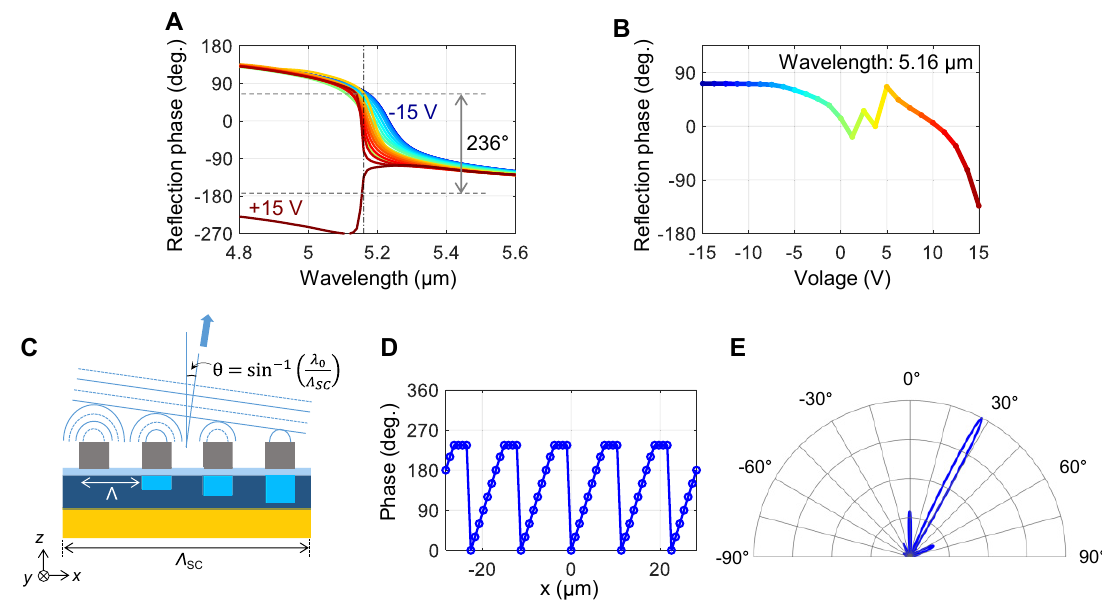
Figure 4: Phase modulation and beam steering of mid-infrared light. (A)Reflectionphasespectrumfordifferentvoltagesof − 15V(theblueline)to + 15V(theredline),showingthetransitionfromtheover-coupling (theblueline)totheunder-coupling(theredline)regimes.(B)Relativechangeofthere fl ectionphaseatthewavelengthof5.16 μ mdenotedby the vertical dash-dotted line in (A), showing the continuous phase sweep up to 236 ° . (C) Schematic cross-sectional view of the phase-tunable metasurface,whereweassumethateachAlantennaisfedbyapropervoltagetoproduceasaw-toothphasegradient.Thesteeringangle θ can be controlled by changing Λ SC . (D) An example of phase distribution with super cells composed of 12 antennas. (E) Far- fi eld intensity as a function of the angle, showing well-de fi ned main lobe at the designed angle of 27.2 ° .